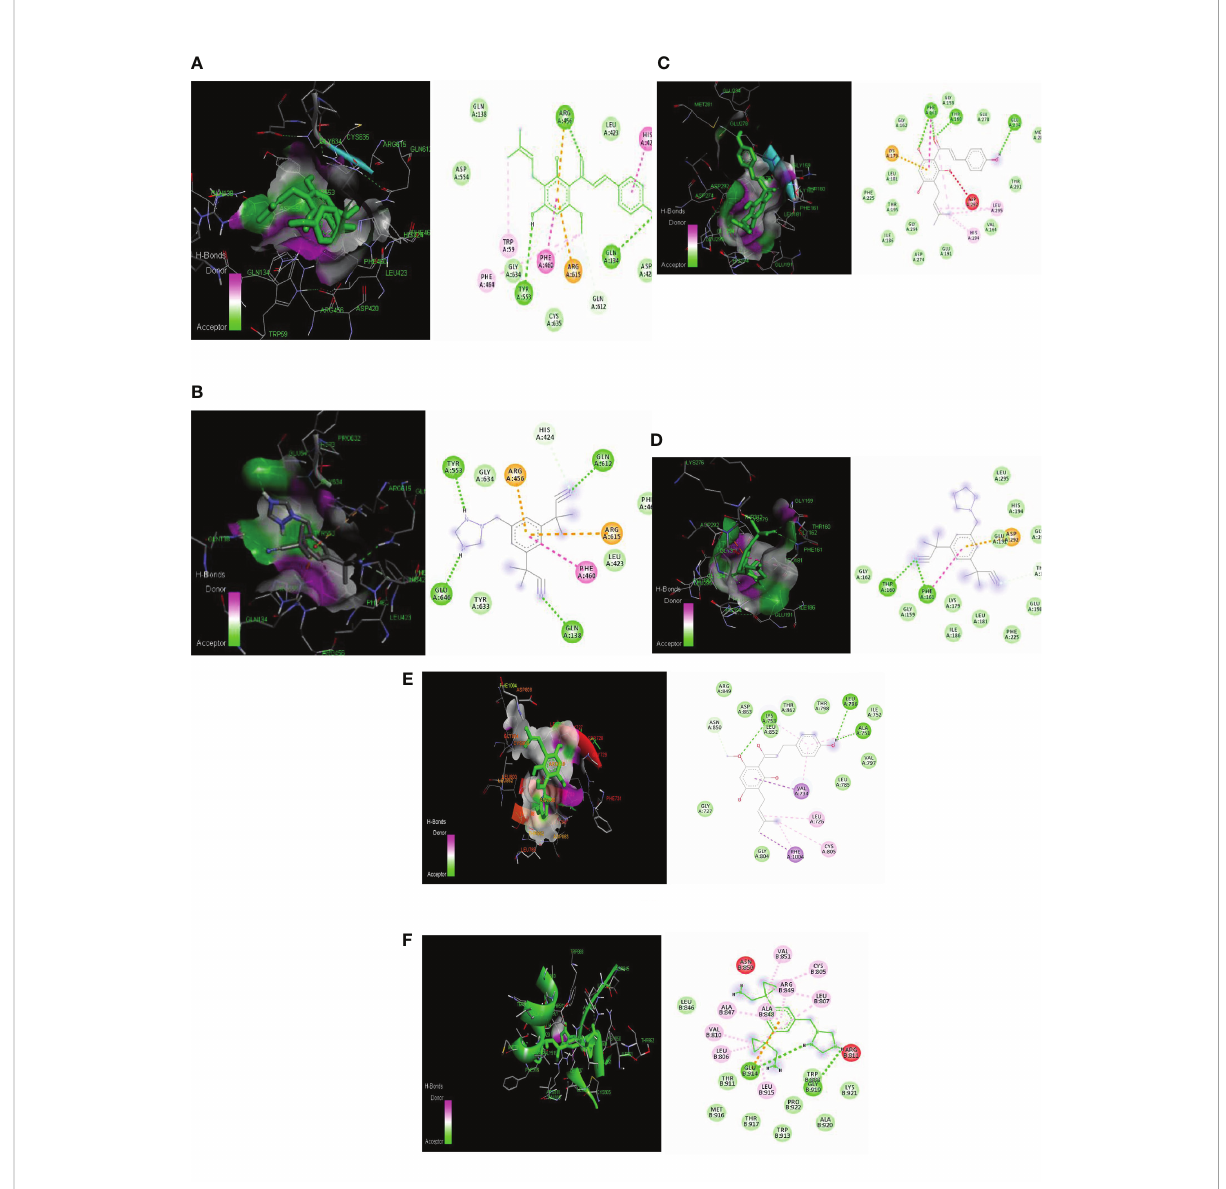
FIGURE 3 Lowest energy docking structure of (A) PI3K-Xanthohumol (B) PIK-Anastrozole, (C) AKT-Xanthohumol, (D) AKT-Anastrozole, (E) HER2- Xanthohumol, and (F) HER2-Anastrozole along with their 2D interactions.